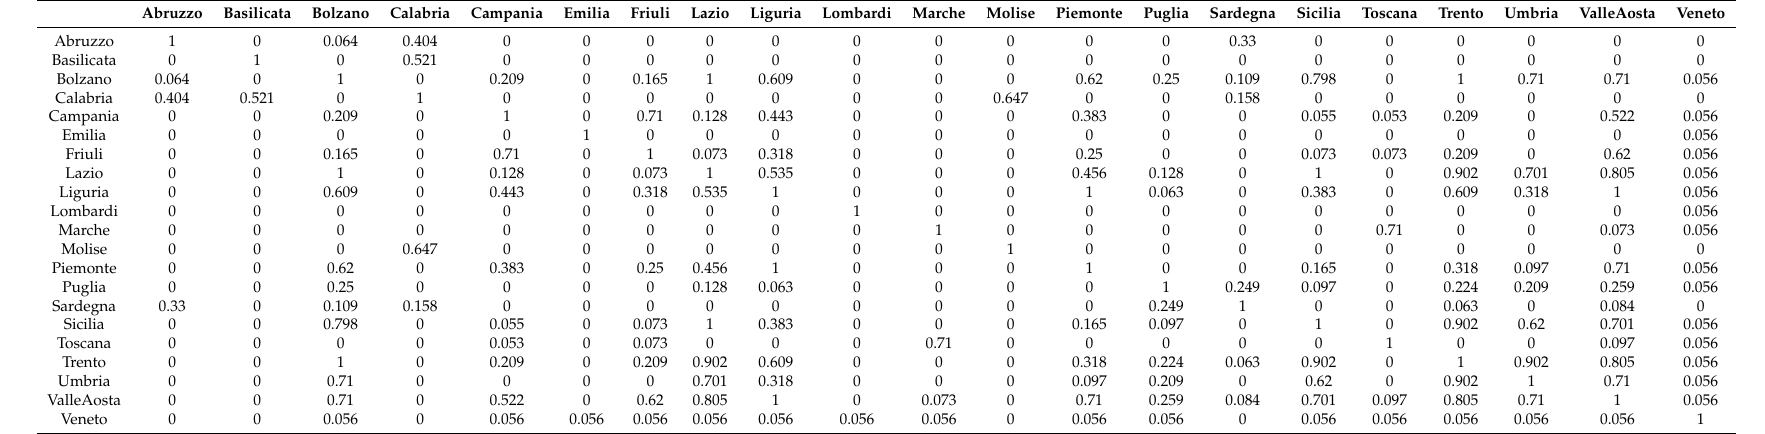
Table A22. Similarity values of Home Isolation network in the third